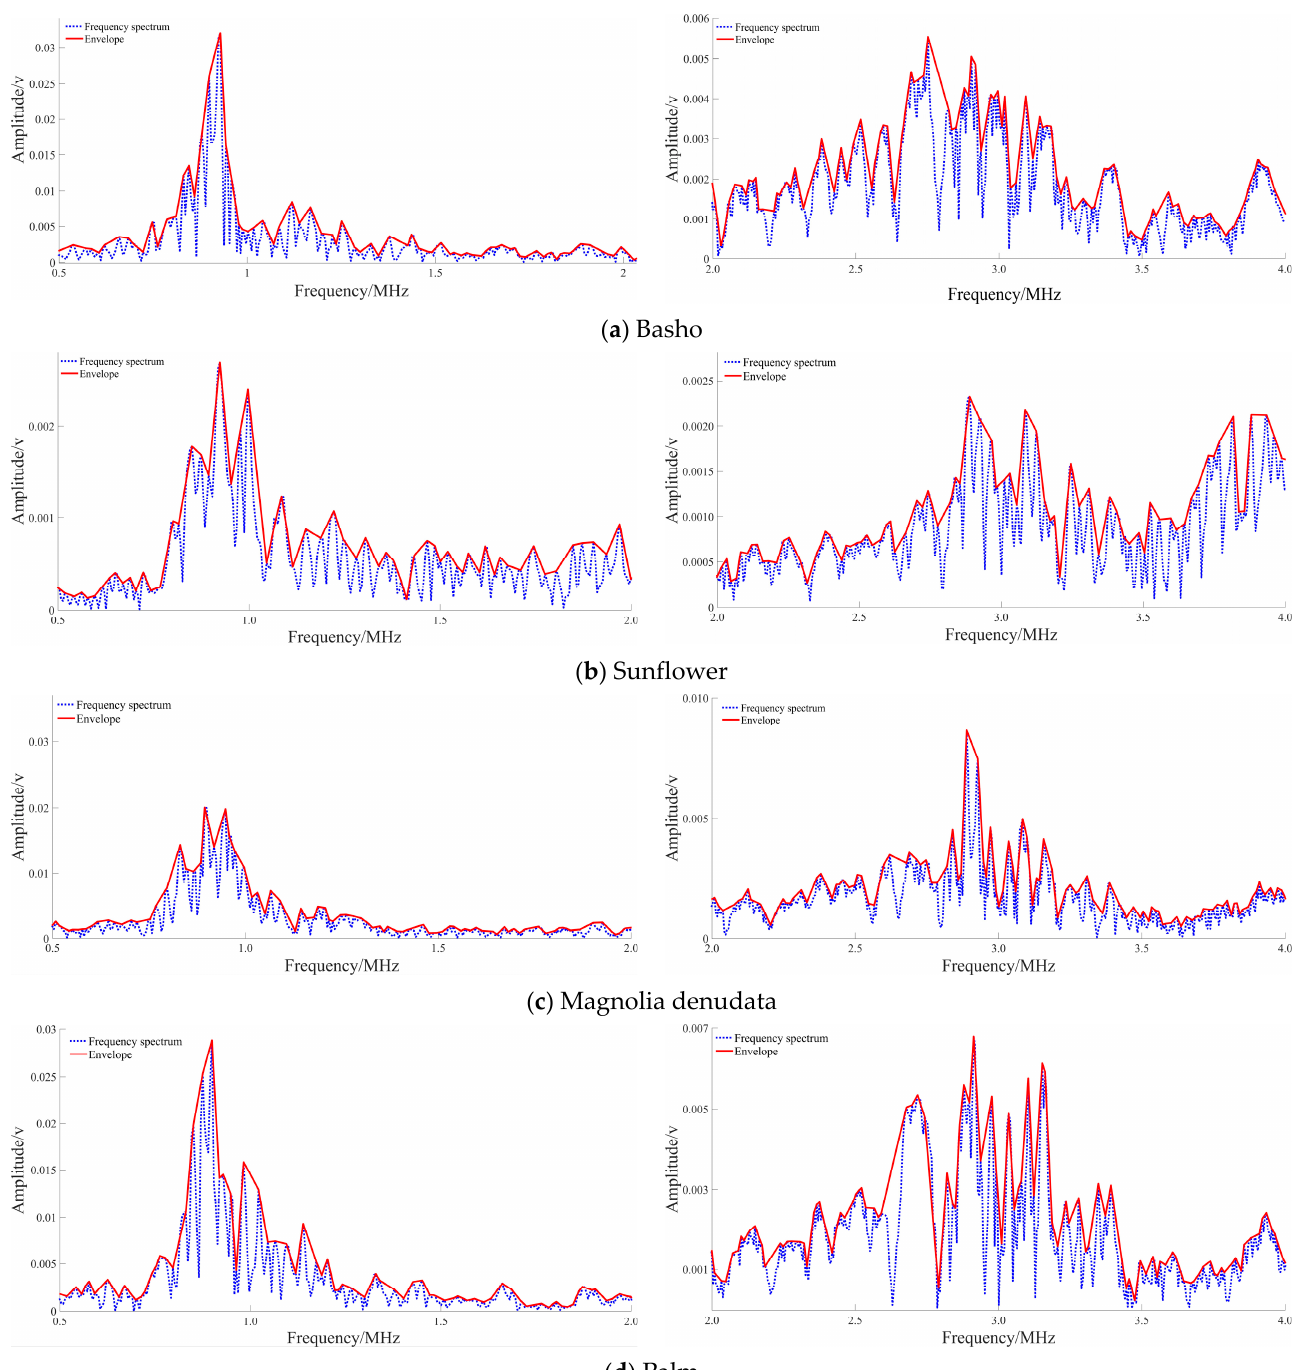
Figure 5. Segments of ultrasound amplitude-frequency of plant stems.